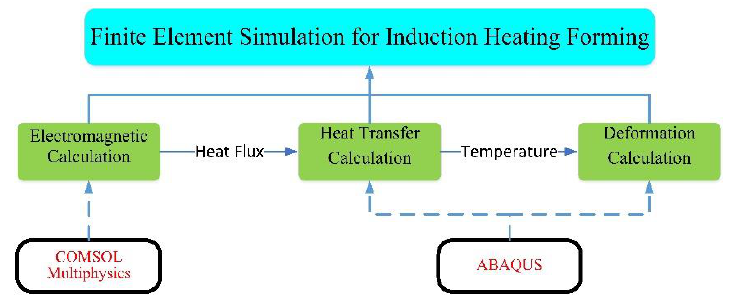
Figure 1. Overall calculation process of the induction heating.